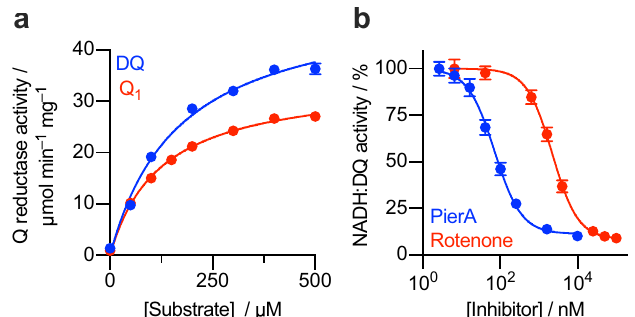
Figure 3. Characterization of purified complex I from P. denitrificans. ( a ) K M curve for DQ and Q 1 substrates for a typical sample of soluble complex I. The K M values for DQ and Q 1 are 169 ± 15 and 124 ± 8 µM, respectively (± S.E. of the fit). ( b ) Piericidin A and rotenone IC 50 titration curves for soluble complex I, using DQ as the substrate. The IC 50 values of piericidin A and rotenone are 72 ± 7 nM and 2226 ± 185 nM, respectively (± S.E. of the